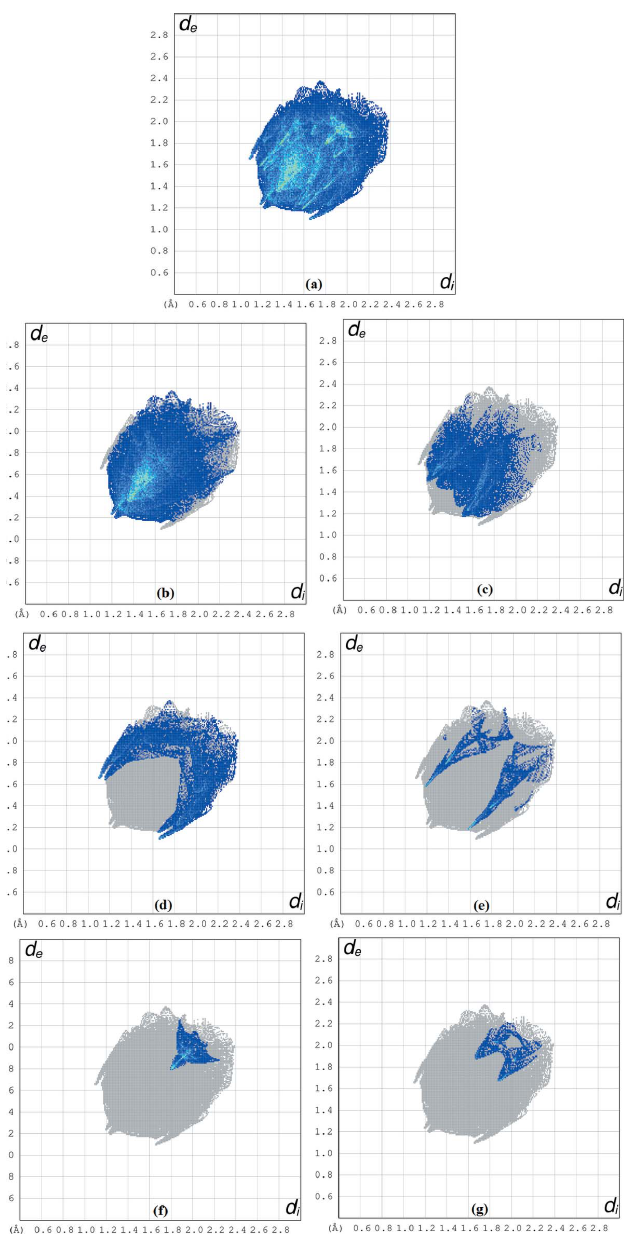
Figure 5 The two-dimensional fingerprint plots for ( a ) all interactions and those delineated into ( b ) H (cid:3)(cid:3)(cid:3) H, ( c ) H (cid:3)(cid:3)(cid:3) O/O (cid:3)(cid:3)(cid:3) H, ( d ) H (cid:3)(cid:3)(cid:3) C/C (cid:3)(cid:3)(cid:3) H, ( e ) H (cid:3)(cid:3)(cid:3) N/N (cid:3)(cid:3)(cid:3) H, ( f ) C (cid:3)(cid:3)(cid:3) C and ( g ) C (cid:3)(cid:3)(cid:3) O/O (cid:3)(cid:3)(cid:3) C